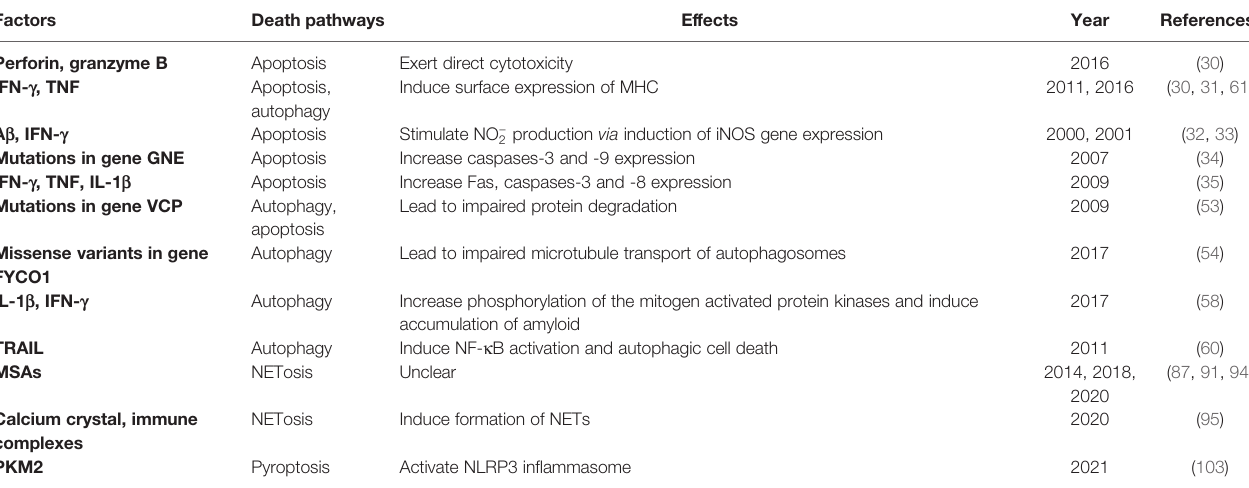
TABLE 1 | Factors inducing abnormal myocyte death in